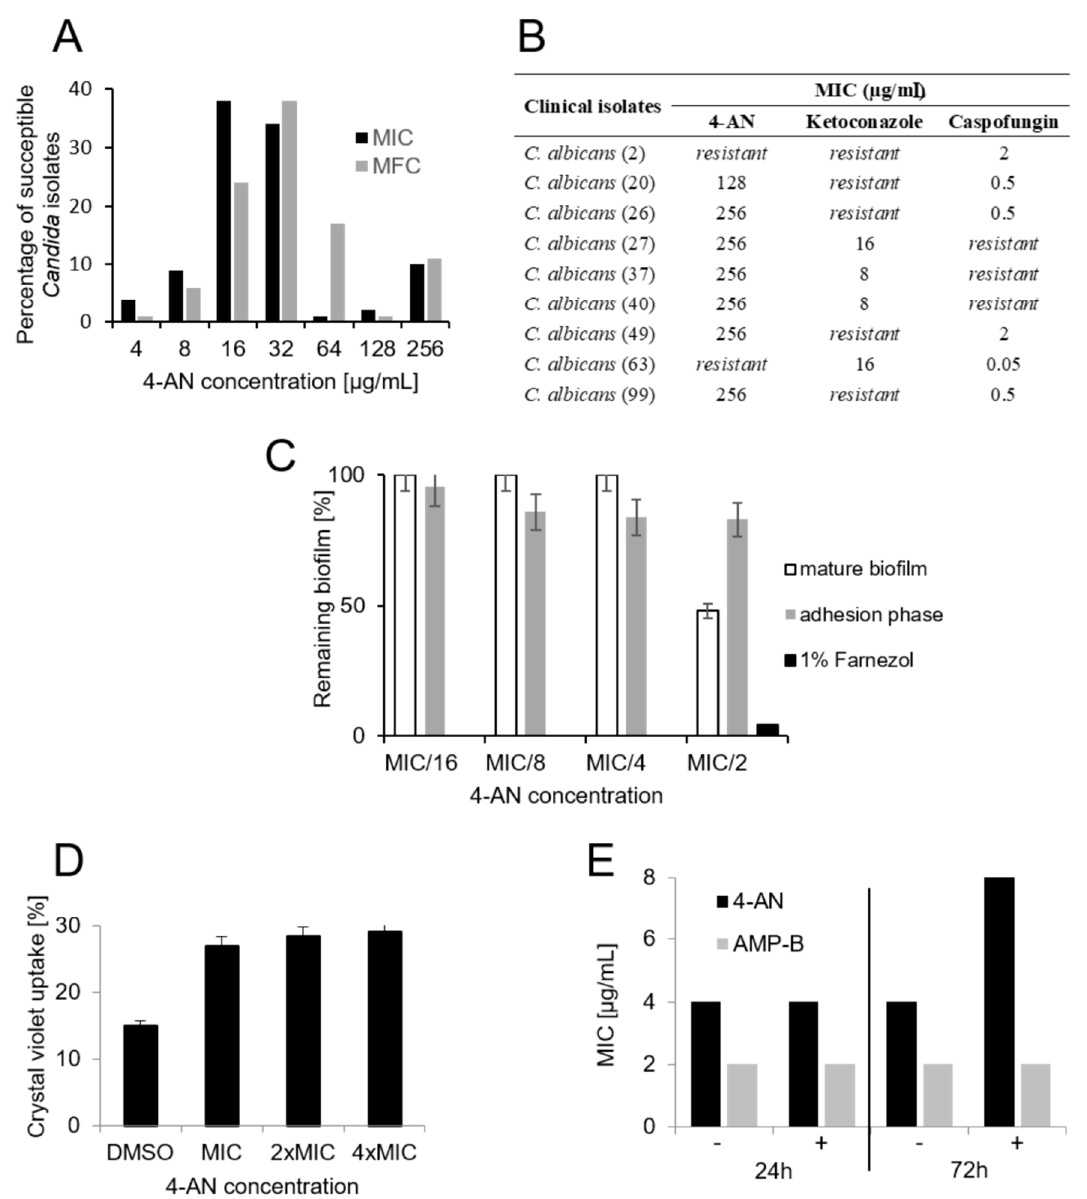
Figure 2. ( A ) Fungicidal and fungistatic effect of 4-AN on clinical Candida isolates. ( B ) Influence of 4-AN on resistant C. albicans isolates, ( C ) influence of 4-AN on Candida biofilm. ( D ) Influence of 4-AN on crystal violet uptake by C. albicans cells. ( E ) Osmoprotective effect of sorbitol on C. albicans cells treated with 4-AN.